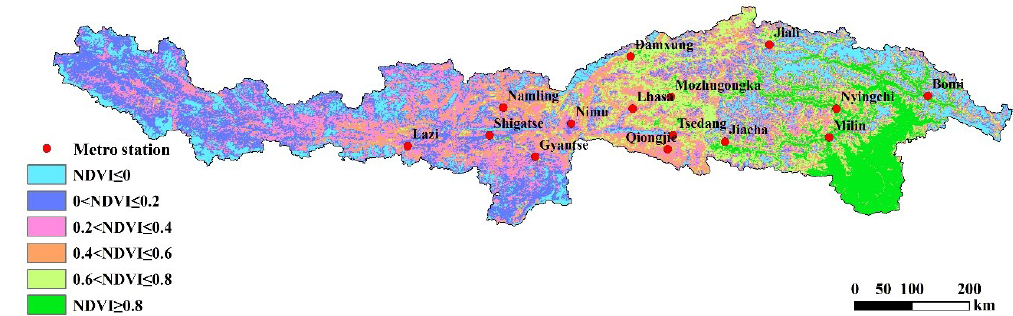
Figure 6. Spatial distribution of NDVI during the growing season of 2002 in the Yarlung Zangbo River Basin.